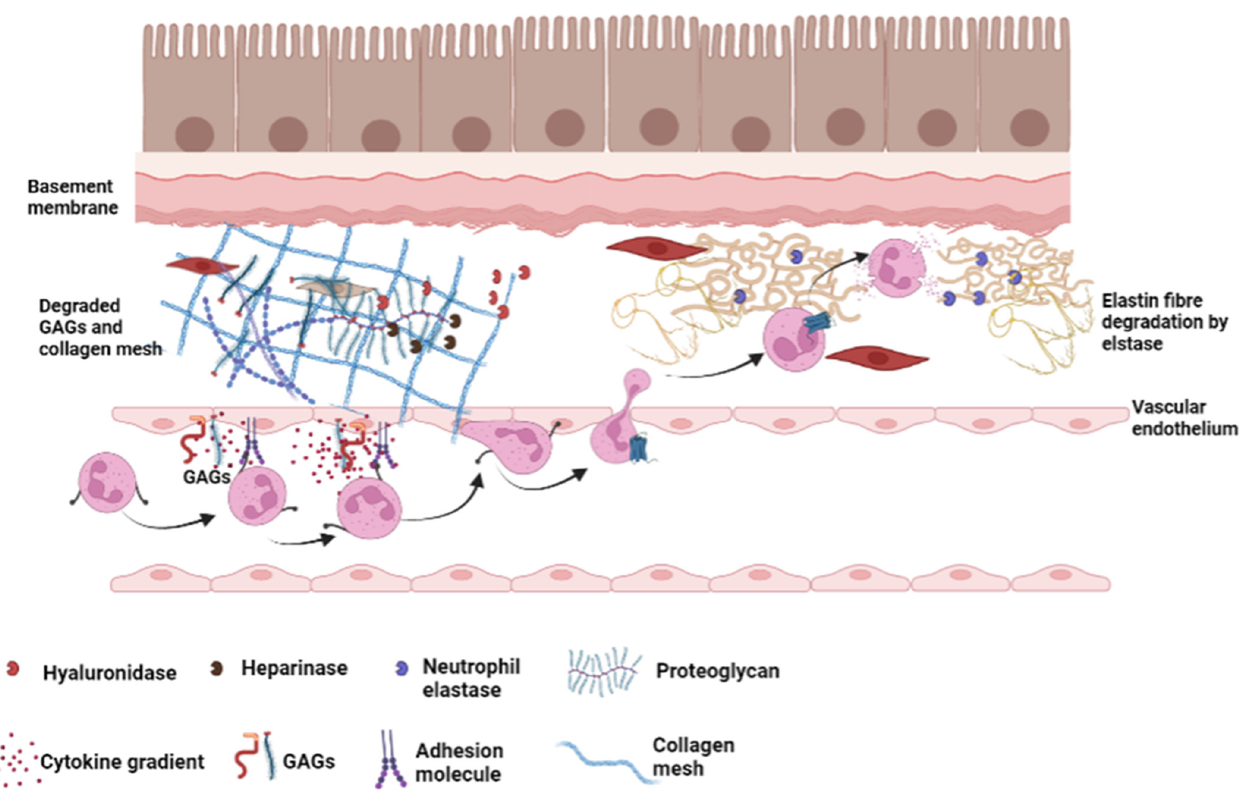
Figure 3. Remodelling of the extracellular matrix in COPD: Neutrophils that extravasate through the endothelial cells to the airways are drawn by cytokine gradients created by glycosaminoglycans (GAGs) on the endothelial surface. The neutrophils release neutrophil elastase (NE) that degrades elastin fibres in the ECM. Within the ECM, there is high activity of GAG lyases such as hyaluronidase and heparinase that cause degradation of GAGs leading to structural changes in the ECM that affects the airway wall thickness and elasticity.